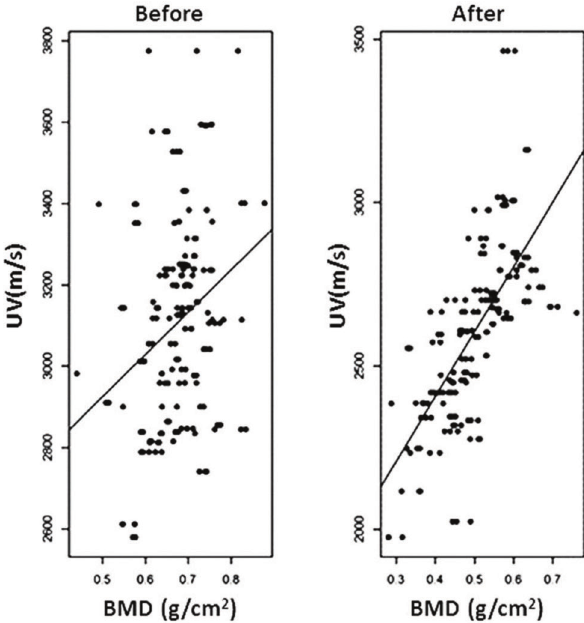
Figure 7 - Graph of the individual UV x BMD dispersion before and after demineralization. The concentration of the dots around the average line is evident after demineralization.